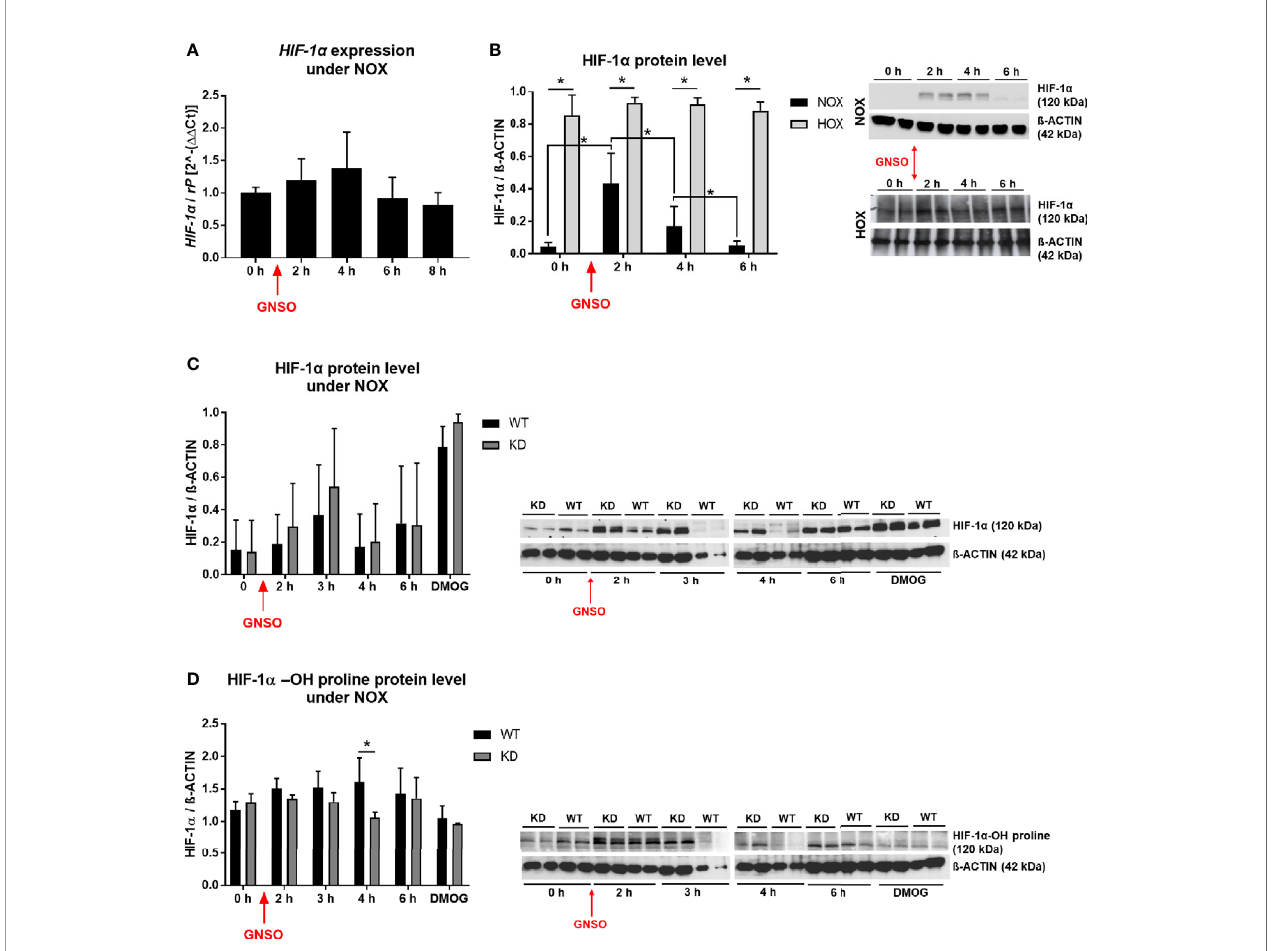
FIGURE 4 | HIF-1 a under NO treatment. HIF-1 a expression level (A) and HIF-1 a protein level (B) in WT MDA-MB-468 monolayer cells treated with 500 μM GNSO for up to 8 h under normoxia (21% O2) and for protein analysis also hypoxia (1% O2), where cells had already been under HOX for 24 h before addition of GNSO. HIF-1 a expression was not altered after GNSO addition. Expression normalized to ribosomal protein S16 (rP); mean +/- sd; n = 4 - 6 in 3 independent experiments. Under normoxia, HIF-1 a protein signi fi cantly increased 2 h after addition of GNSO while reaching basal levels again after 6 h. Under hypoxia, overall HIF-1 a signi fi cantly increased compared to normoxic conditions whereas GNSO addition led to no additional changes of HIF-1 a level. HIF-1 a (120 kDa) normalized to ß- ACTIN (42 kDa) as house-keeping gene; mean +/- sd; n = 12 in 4 independent experiments (NOX) and n = 4 in 2 independent experiments (HOX). (C, D)